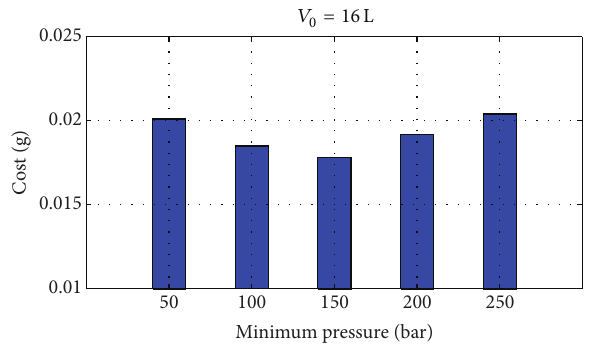
Figure 9: Fuel consumption with the different 𝑝 0 under the same = 16 𝑉 0